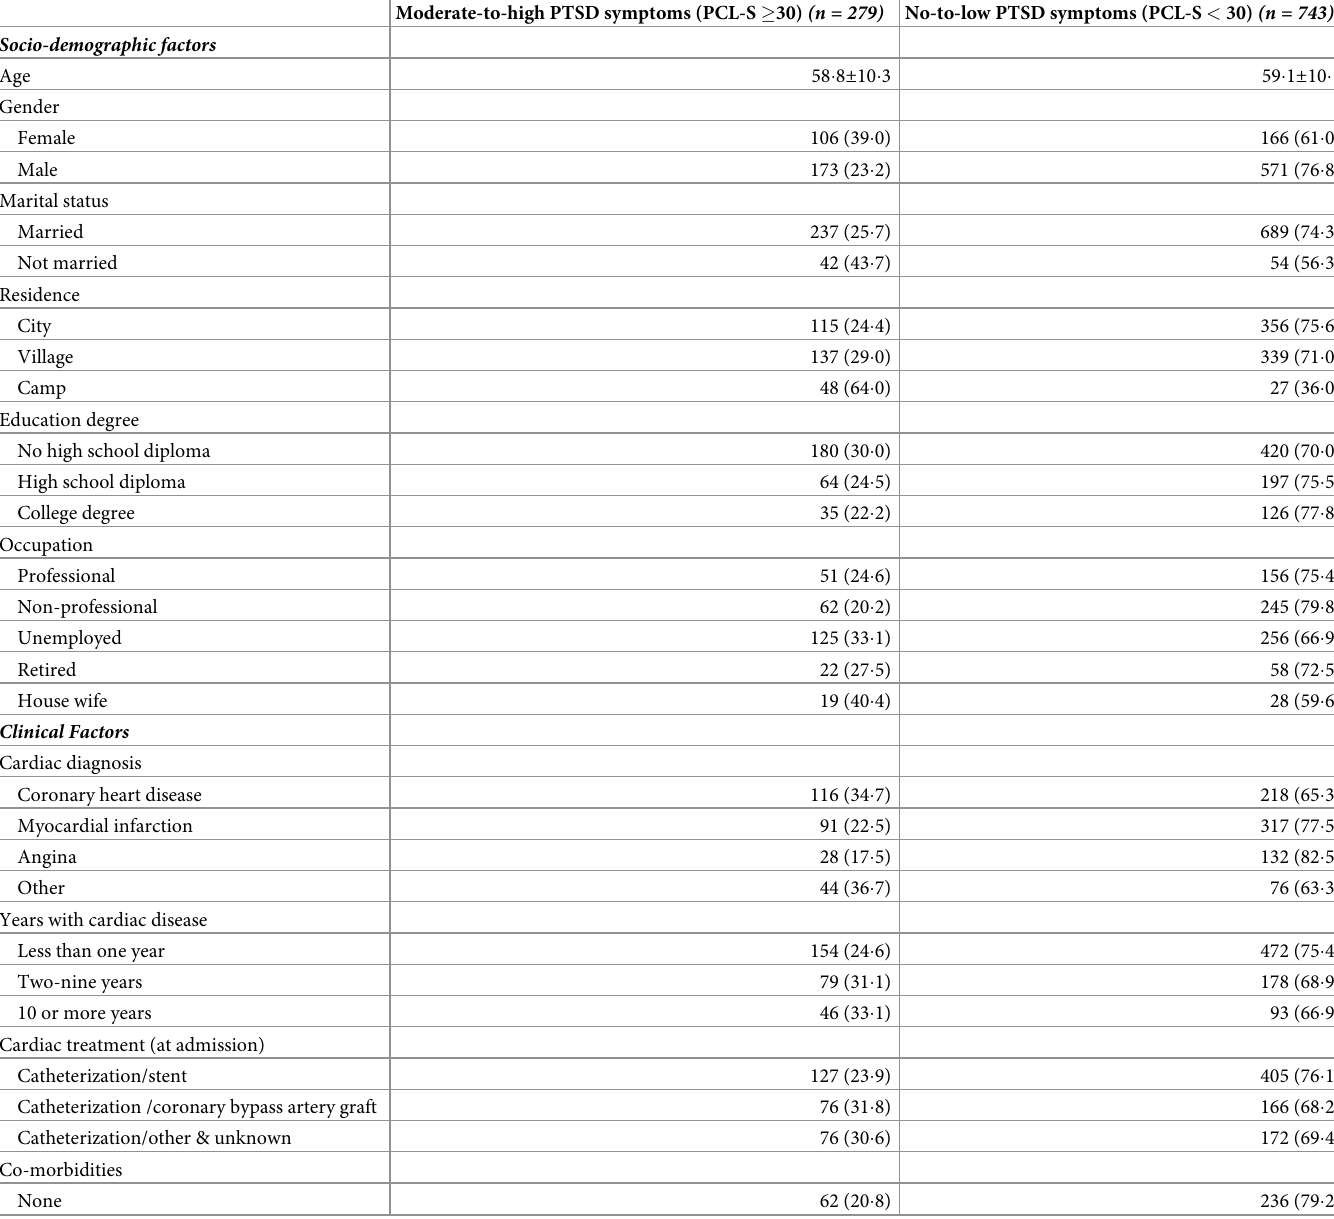
Table 1. Socio-demographic, clinical, psychosocial and lifestyle characteristics at baseline, by PTSD status, n =